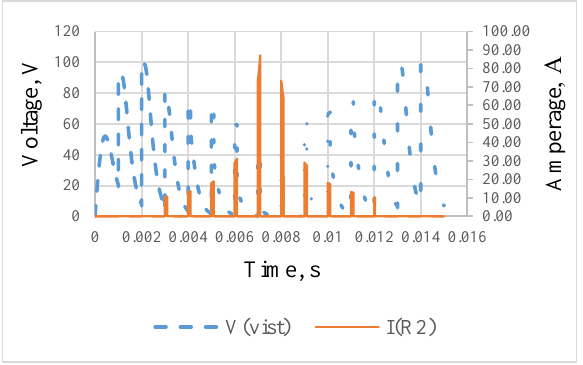
Fig. 4. Simulation results for linear reduction and increase of the interelectrode gap (voltage-dashed line, current –